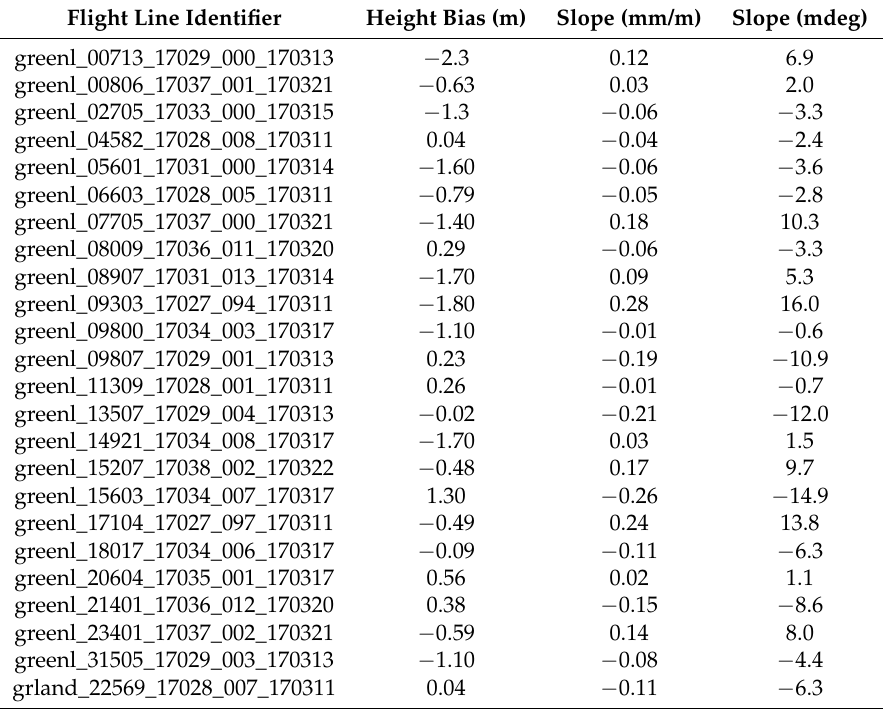
Table A2. Summary of 2017 lines validated with ATM data summarizing residual linear trends (GLISTIN −